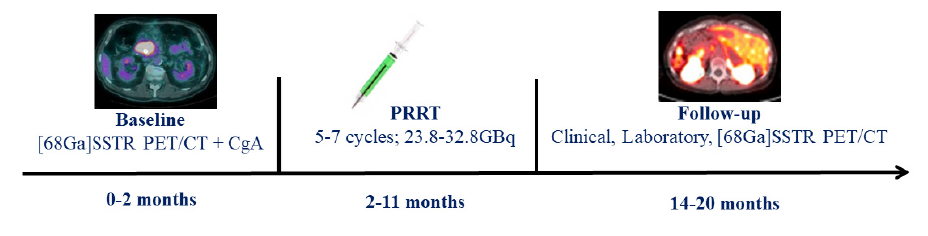
Figure 1. Study workflow.